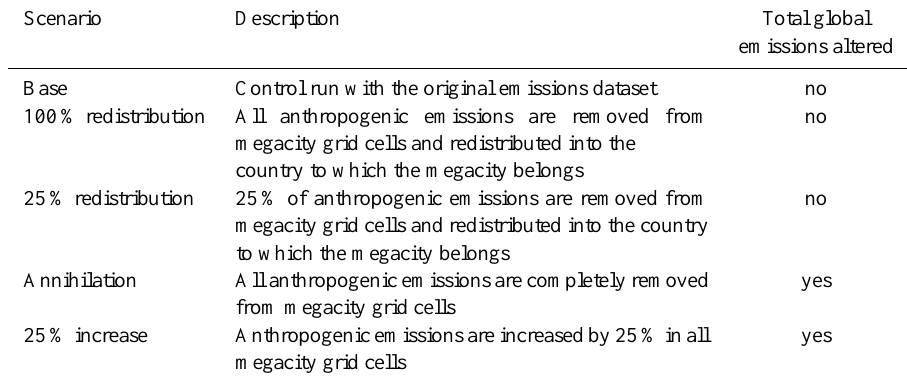
emissions altered no no yes